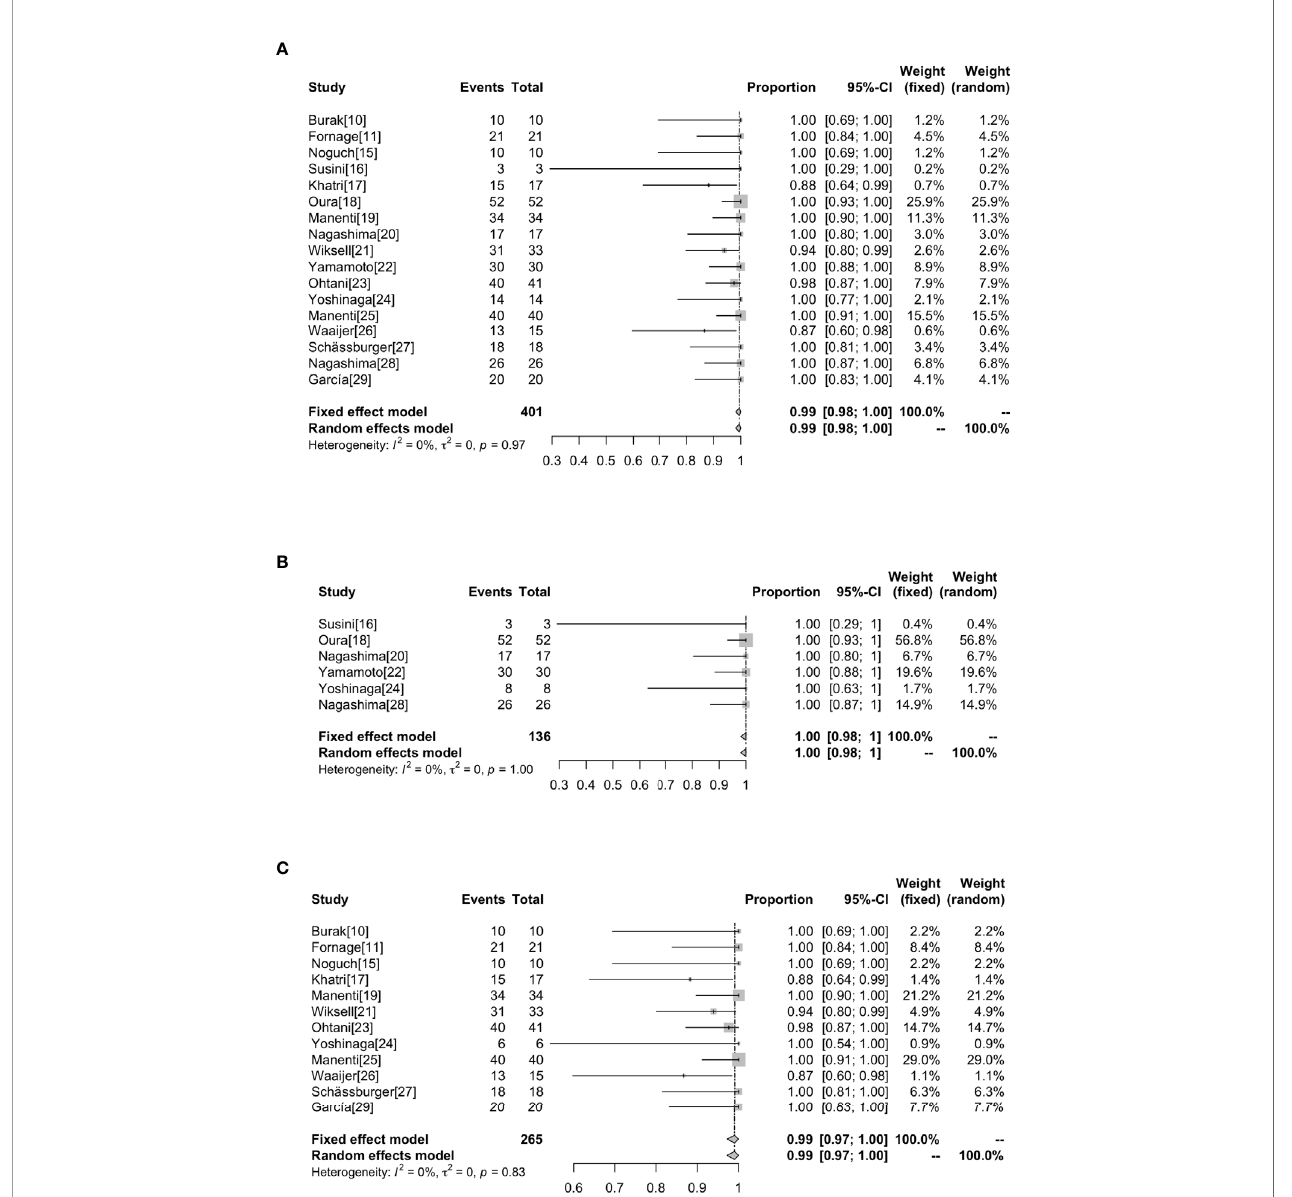
FIGURE 2 | Forest plot showing the analysis of technically successful ablation rate in patients. The results of all the patients (A) , patients without surgical resection following RFA (B) , patients with surgical resection following RFA (C) are shown,